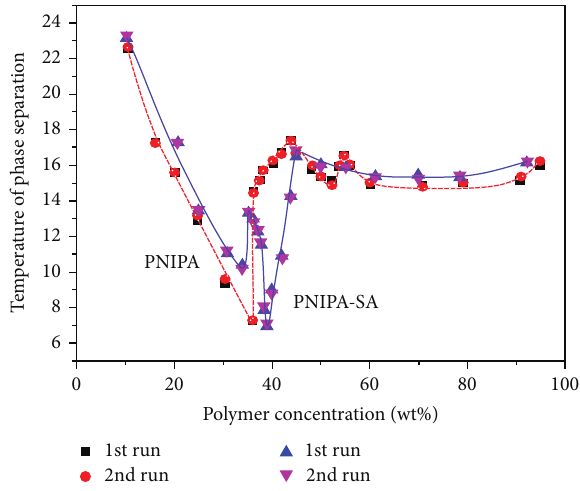
Figure 7: A comparison of phase diagrams of PNIPA and PNIPA- SA/water systems.